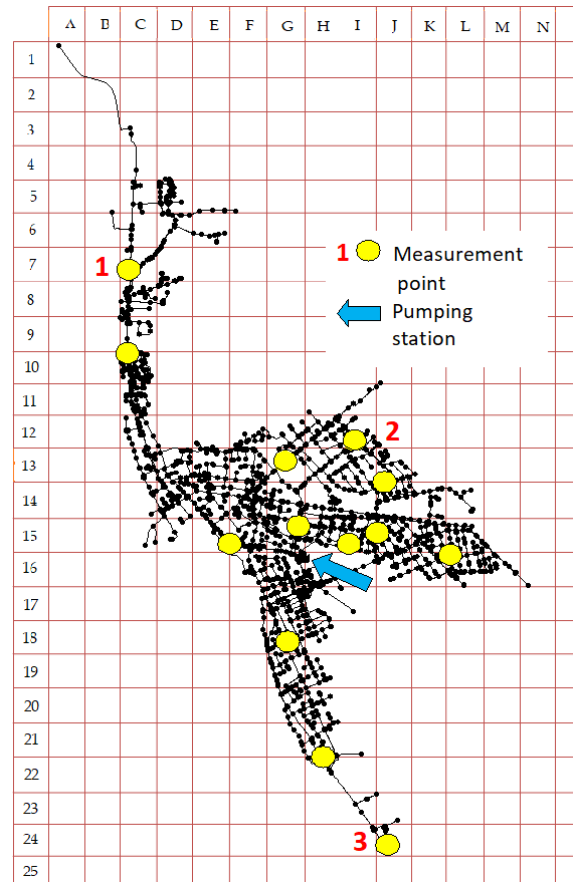
Figure 2. Geometric structure of the network represented in a numerical model along with the location of exemplary free chlorine measurement points used in the calibration process and the employed grid of subareas. Table 3. Calibration statistics for chlorine concentration (EPANET).